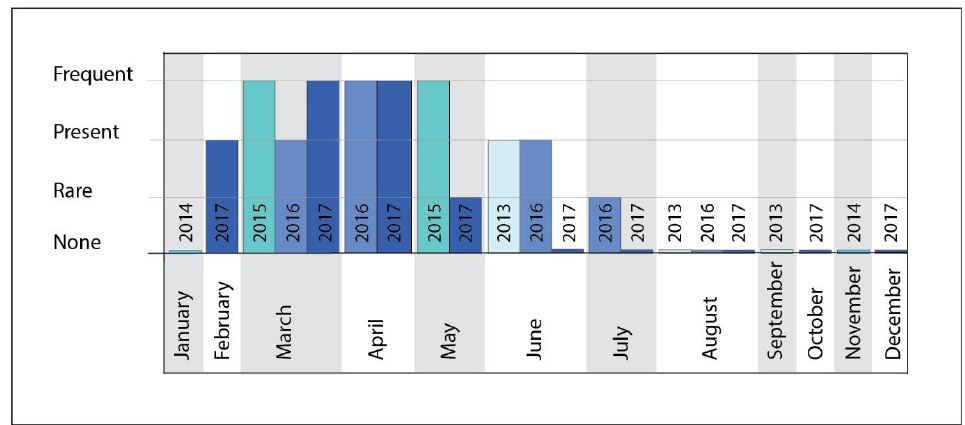
Figure 7. Estimation of the monthly abundance of MgAs micropearls (MC5) in Lake Geneva. Organ- isms forming this type of micropearls are observed between February and July.